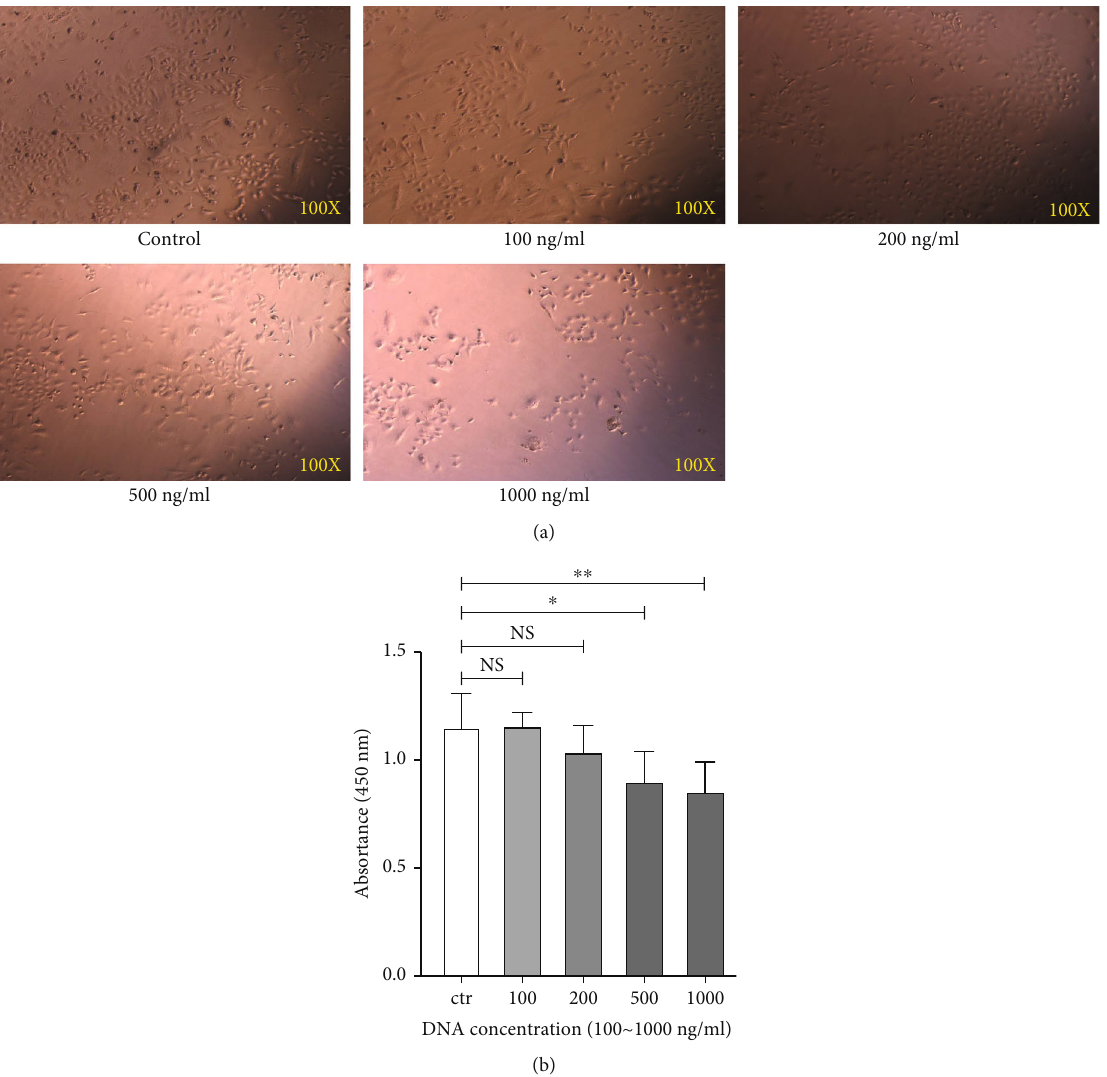
Figure 1: Neutrophil extracellular traps (NETs) damage alveolar epithelial cells in a dose-dependent manner. (a) A549 cells were cultured with di ff erent concentrations of NETs, and the morphological changes were observed under an optical fi bre microscope. Representative images of the A549 cells are shown. (b) The proliferation of A549 cells was further detected using an enzyme-plate analyser. Values are expressed as mean ± standard error of the mean (SEM) of three independent experiments ( ∗ P < 0 : 05 and ∗∗ P < 0 : 01 ; NS: not signi fi